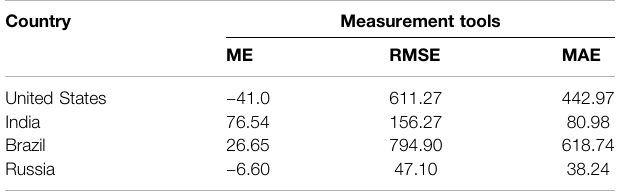
TABLE2| Numberofdailycon fi rmedcasesoftheUnitedStates,India,Brazil,and Russia. Country Measurement tools